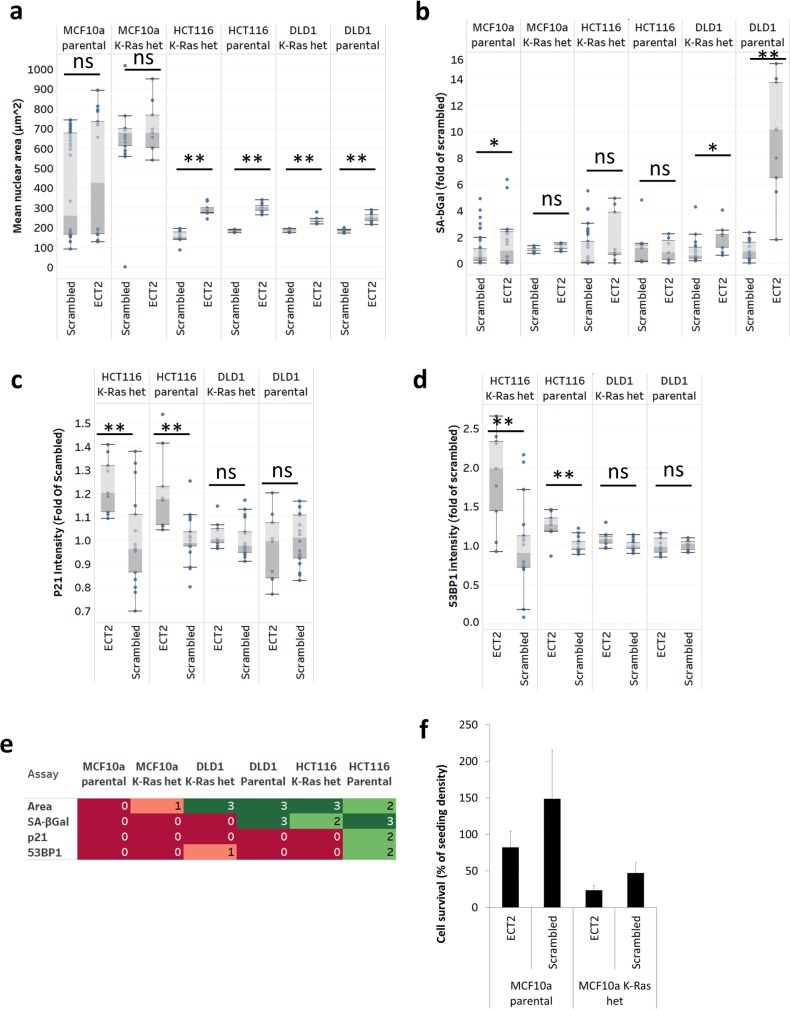
Senescence engagement is more robust in the presence of activating KRASG13D mutation in colorectal carcinoma cell lines.(a) Mean nuclear area per well (μm2), (b) mean SAβGal expressed as fold of scrambled for each individual cell line, (c) mean p21 nuclear intensity expressed as fold of scrambled for each individual cell line, (d) mean 53BP1 spots (foci) per nuclei expressed as fold of scrambled for each individual cell line. Box whisker plots generated in Tableau desktop represent triplicate wells in 3 independent transfections. Boxes represent the 25th– 75th percentile of the data. Median level is shown as a colour change within the box. P-values were calculated by 2-tailed Student’s T-test in Excel assuming unequal variance: (*) p<0.05, (**) p<0.001. (e) heat-maps drawn in Tableau desktop representing hit (green) and miss (red) for mean nuclear area, SAβGal, p21 and 53BP1 in MCF10a parental and KRASG13D/+ knock-in cells compared to HCT116 and DLD1 parental and KRAS+/- G13D knock-out cells transfected with siRNA targeting ECT2. Hits were classed as ≥ 2/3 wells in ≥ 2/3 independent experiments passing the cut-off of mean scrambled control + 3 standard deviations. Values in heat-map boxes represent the number of repeat experiments in which at least 2/3 siRNA gave results greater than scrambled mean + 3SD. Mean number of objects (nuclei) per well was used as a measure of proliferation, toxicity or cytostasis (f). Graphs represent the mean and standard error of mean number of objects from triplicate wells in 3 independent experiments expressed as a percentage of the initial seeding density (3000 cells). 100–150% was taken as no growth (cytostasis), <100% was taken as toxic.